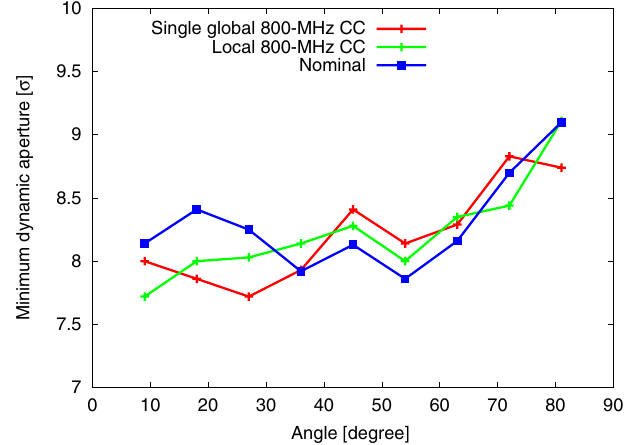
FIG. 31. (Color) Minimum dynamic aperture over 60 error seeds for the nominal LHC optics with or without crab cavity; includ- ing all the head-on and long-range beam-beam interactions at IP1, IP2, IP5, and IP8. The dynamic-aperture tracking is per- formed for 100 000